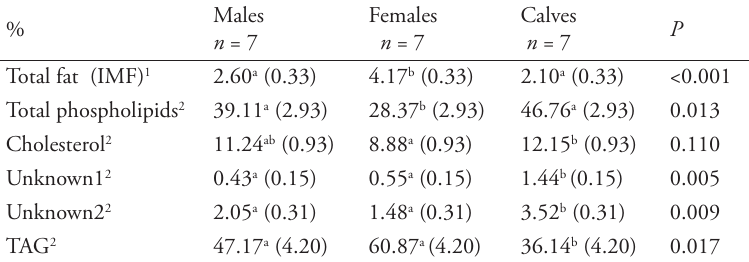
Table 3a. Fat content and main lipid class composition of free ranging reindeer of dif- ferent age and sex (least-square means and standard errors) Males %